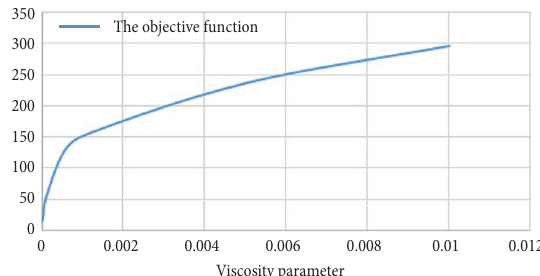
Fig. 15. The values of the objective function versus different viscosity parameters in dual-border cut test